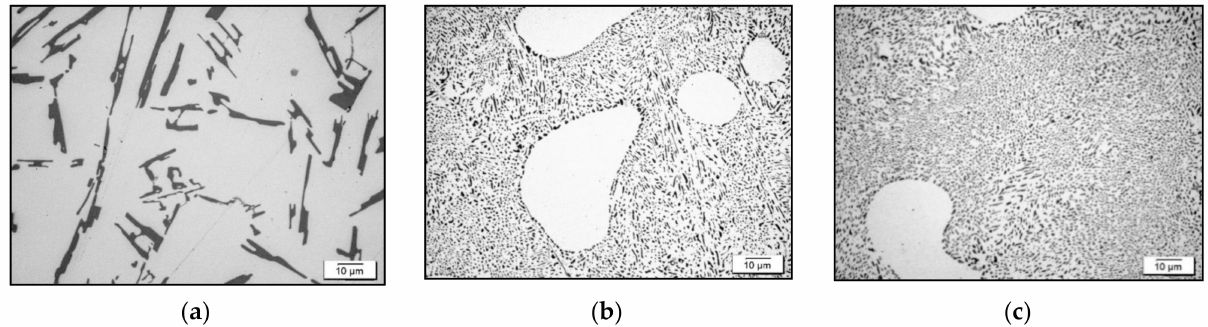
Figure 1. Microstructure of eutectic alloy 4 depending on treatment: ( a ) untreated; ( b ) standard flux; ( c ) complex